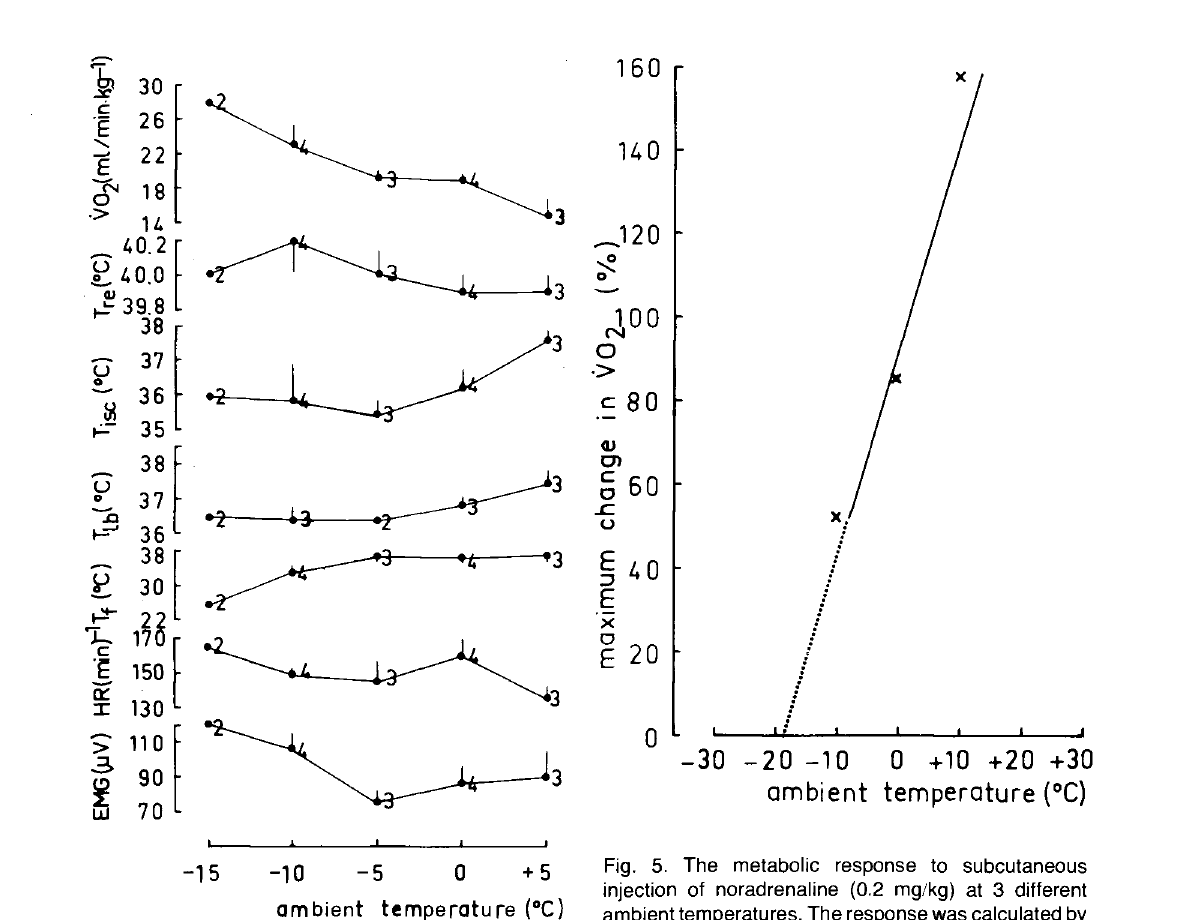
Fig. 5. The metabolic response to subcutaneous injection of noradrenaline (0.2 mg/kg) at 3 different ambient temperatures. The response was calculated by substracting the increase in VO2 above preinjected Fig. 3. Changes in oxygen consumption (VCfc), body levels after NA injection. The broken line described from temperature (T, ), skin temperature above the inters the result shows the probable response to the same e capular (Tisc) and lumbal (Tib) regions, foot temperature dosage of NA in the colder ambient temperature. (Ti), heart rate (HR) and electromyographic activity (y=98.4+5.25 x, r=0.9765, P<0.001). (EMG) in 1 day old reindeer calves at various ambient temperatures. Number of measurements indicated at Reaksjon på omsetningen ved subkutan injeksjon av each symbol. Vertical bars represent standard errors of noradrenalin (NA) (0,2 mg/kg) ved 3 forskjellige mean. omgivelsestemperaturer. Reaksjonen ble beregnet som differensen mellom VO2 før og etter injeksjonen av NA. Forandringer i oksygenforbruket (\ 0_> kroppstempera Den brutte linje beskriver den sannsynlige reaksjon på A tur (Tre), hudtemperaturen over skulder ( TIK ) og lend den samme dose av NA ved lavere omgivelsestemperatur. (Tik), fottemperatur (Tf), hjertefrekvens (HR) og (y=98,4+5,25 x, r=0.9765, elektromyografisk aktivitet (EMG) hos 1 døgn gamle reinsdyrkalver under forskjellige omgivelsestemperatu rer. Antall målinger angitt ved hvert symbol. Vertikale staver representerer standardavvik på midlet.